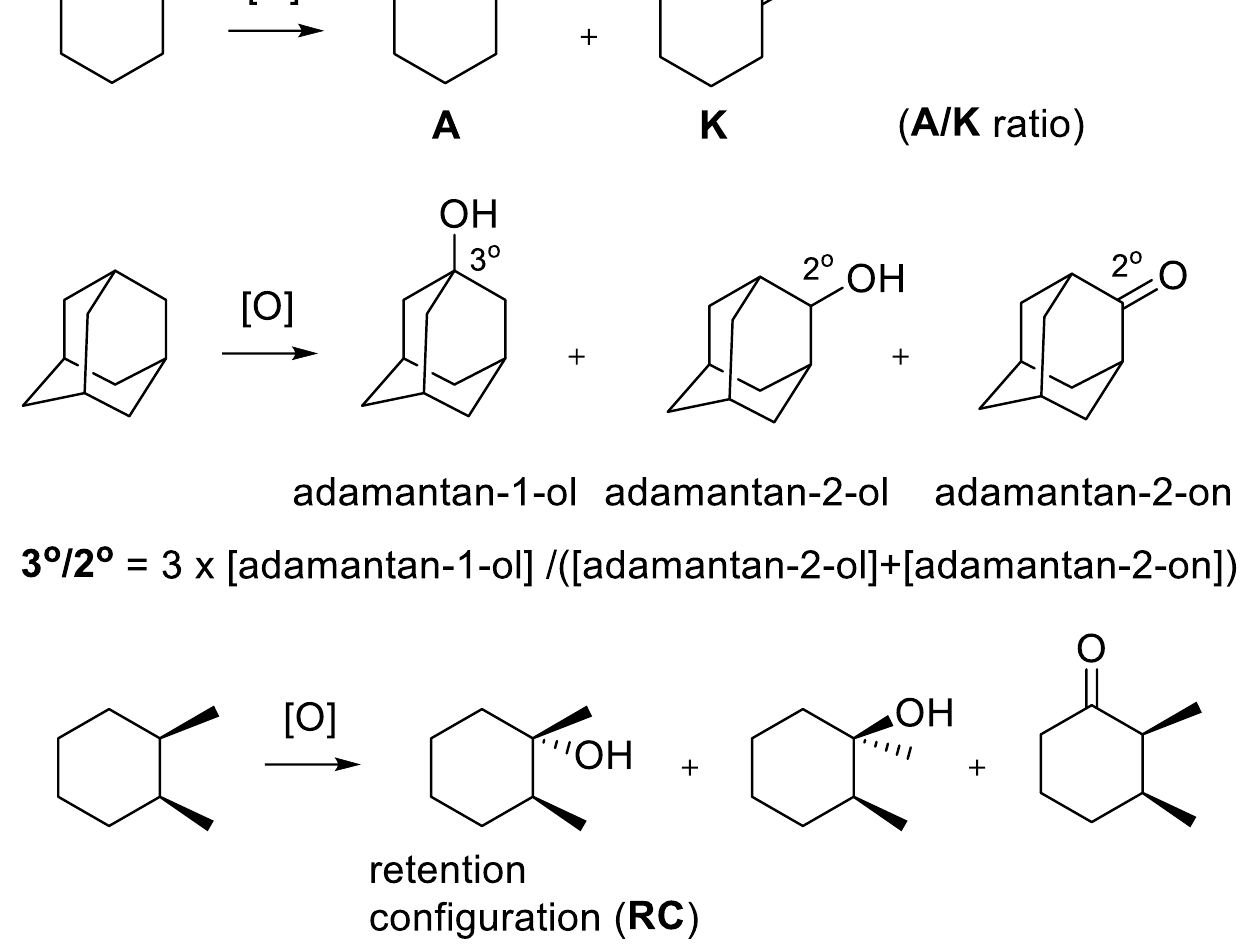
Scheme 1. The main test reactions and parameters help to explore the mechanism of catalytic oxi-